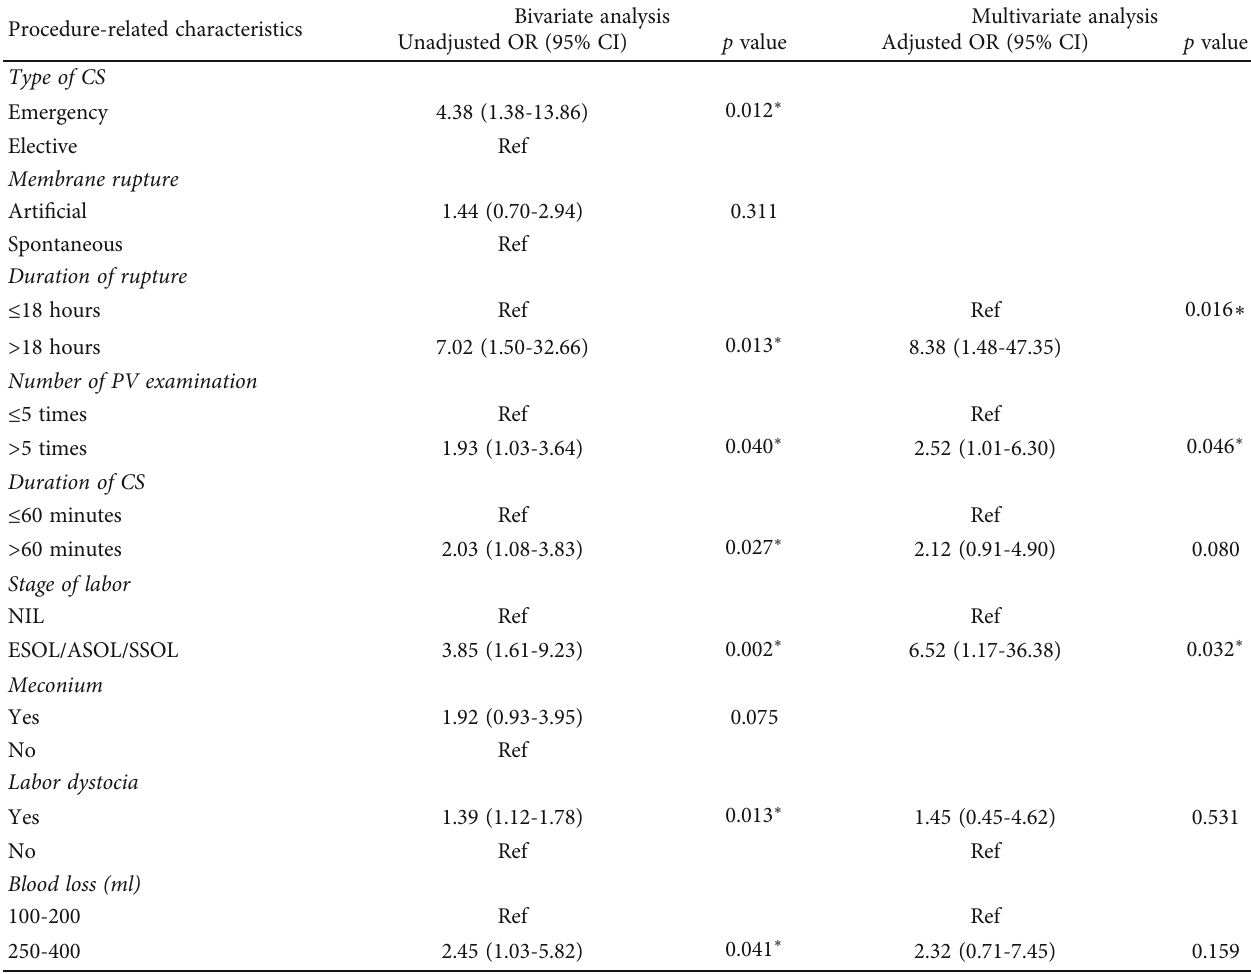
Table 4: Bivariate and multivariate logistic regression model for procedure-related risk factor. Procedure-related